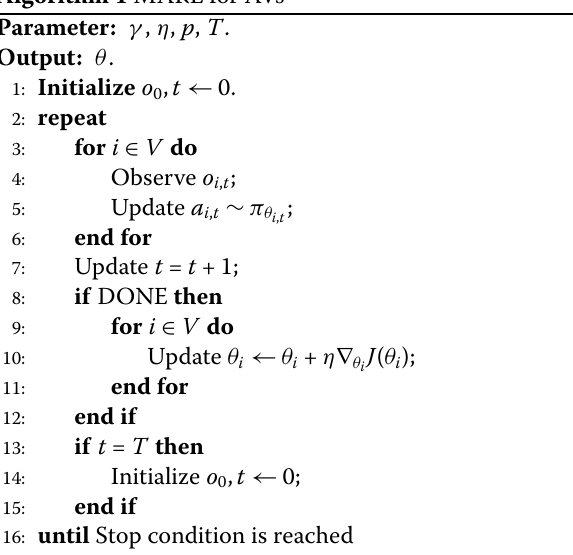
Algorithm 1 MARL for